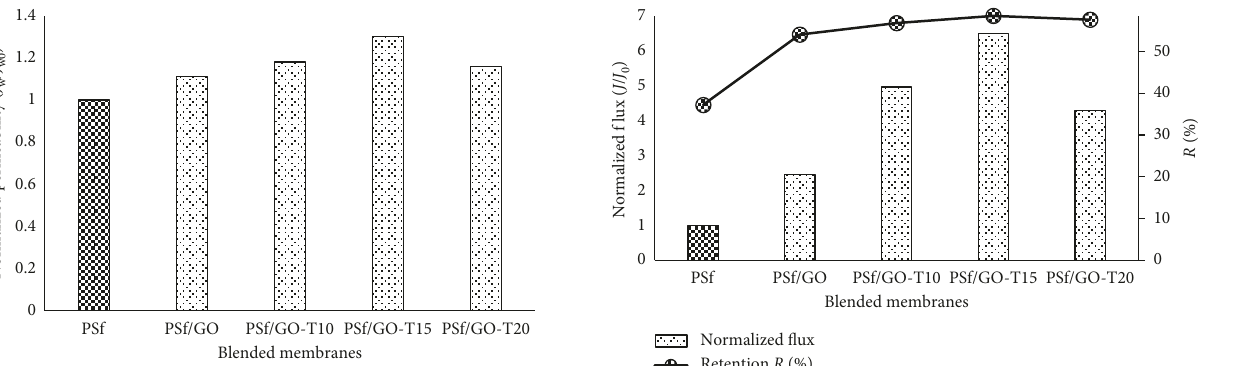
Figure 10: Normalized flux and retention of unblended and blended membranes.